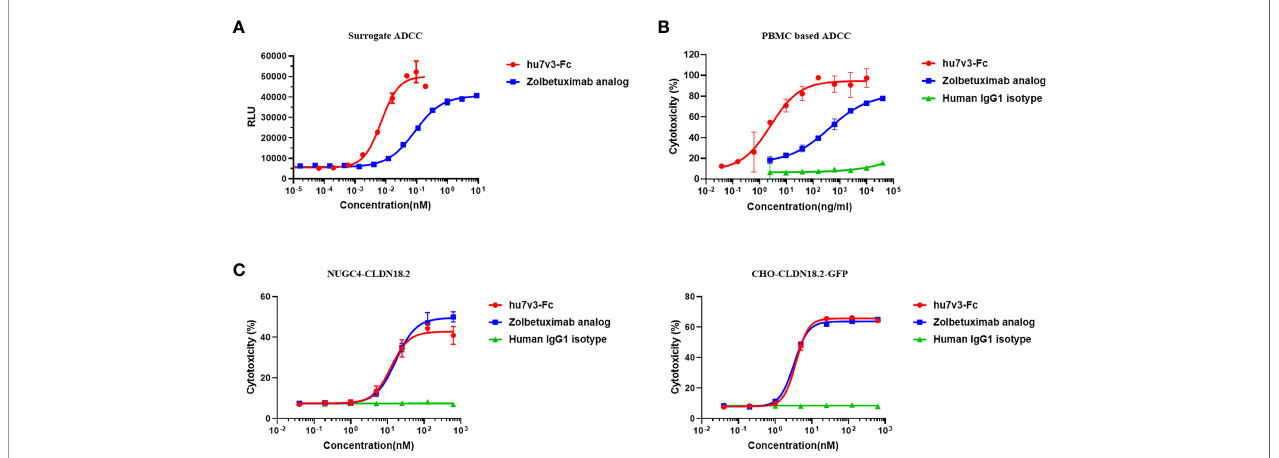
FIGURE 3 | Cytotoxicity analysis of hu7v3-Fc. (A) The surrogate ADCC analysis of hu7v3-Fc. Jurkat cells, engineered to express Fc g RIIIa and NFAT response element-driven fi re fl y luciferase were used as the effector cells, and CHO-CLDN18.2-GFP cells were used as target cells. The effector to target ratio was 5:1. (B) PBMC based ADCC analysis of hu7v3-Fc. Human PBMCs isolated form whole blood were used as the effector cells, and SNU-620 were used as the target cells. The effector to target ratio was equal to 25:1. (C) CDC analysis of hu7v3-Fc. Human AB serum was used as a source of the complement, with NUGC4- CLDN18.2 (left) cells and CHO-CLDN18.2-GFP (right) cells as the target cells,